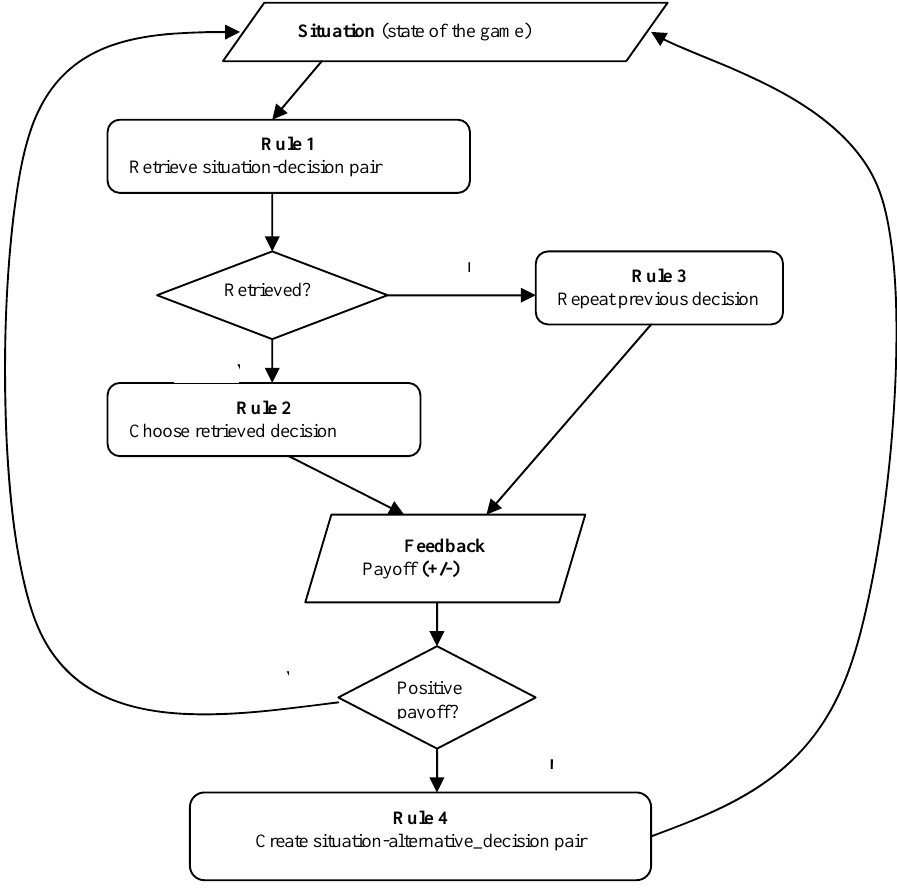
Figure 1. A diagram of the procedural elements of the cognitive model.